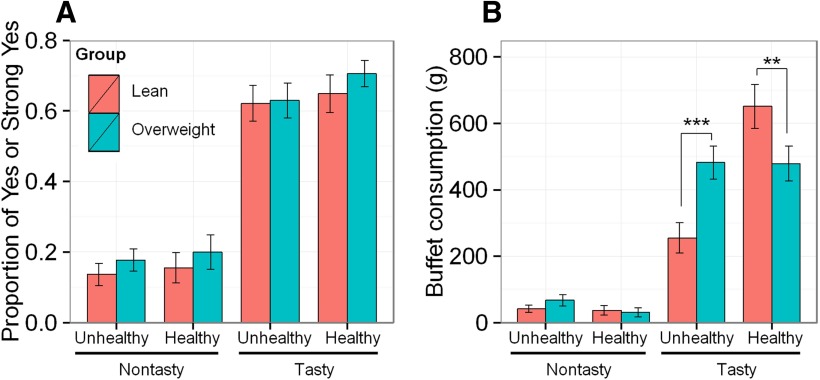
Food choices in the scanner task and in the buffet lunch. A, The proportion of acceptance of food swaps (selecting “yes” or “strong yes”) in the scanner food choice task, across four categories of foods, in lean participants (n = 23) and overweight participants (n = 40). B, Buffet consumption (expressed as the weight of consumed foods) across four food categories, in lean and overweight participants. **p < 0.01, ***p < 0.001. Error bars represent the SEM.